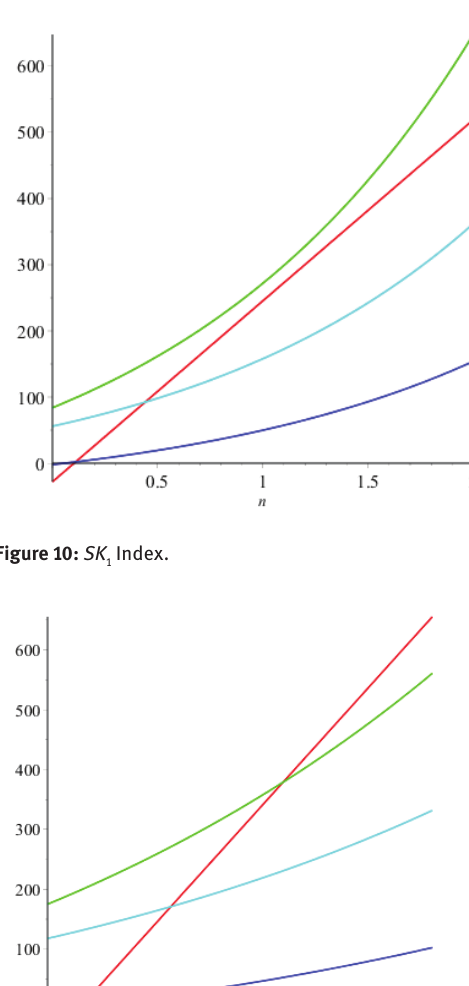
Figure 9: SK Index.